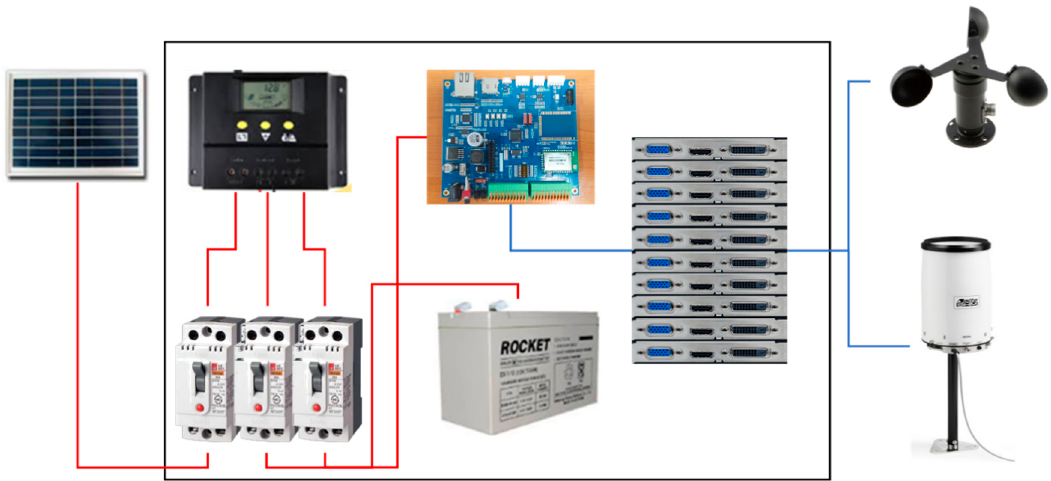
Figure 3. Configuration of energy harvesting.